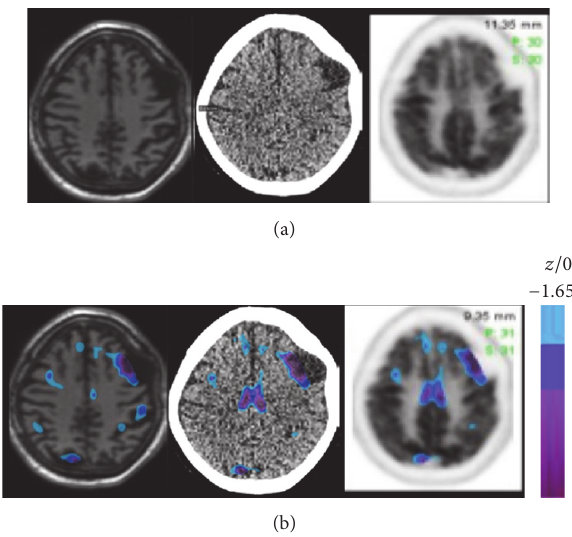
Figure 1: Corresponding transaxial MRI, CT, and FDG PET images (a) with superimposed FDG PET 𝑧 -score images on (b). Findings show a left frontal extra-axial anatomic lesion compatible with arachnoid cyst and focally localized adjacent left dorsolateral frontal cortical glucose hypometabolism on FDG PET. Glucose metabolic reductions greater than 1.65 SD below the normal mean are shown in color